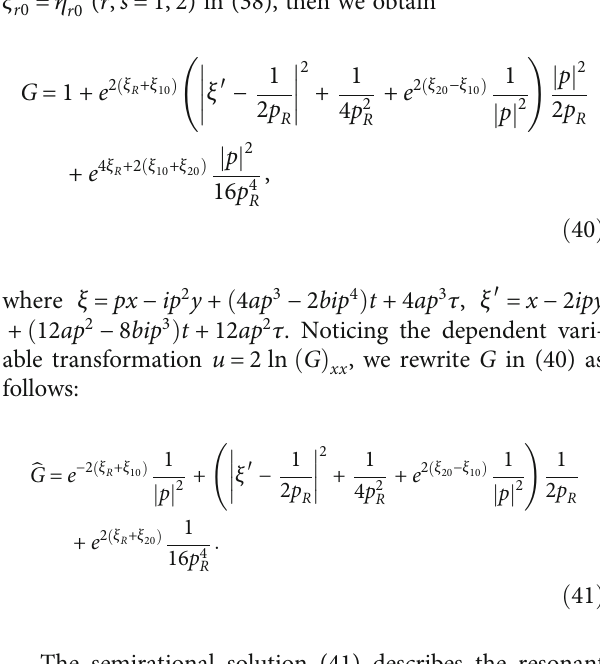
Figure 7: The multiple semirational solution u = 2 ln ð G Þ , where G is given by (36) with p 1 = 1 + i , q 1 = 1 − i , p 2 = 1 + ð 1/2 Þ i , q 2 = 1 − ð 1/2 Þ i xx , a = 1 , b = 1 , τ = 0 , c 11 = 1 , d 11 = 1 , c 21 = 1 + i , d 21 = 1 − i , C 11 = 1 , C 12 = C 21 = 0 , C 22 = 2 , ξ 10 = η 10 = ξ 20 = η 20 = 0 : (a) t = − 1/2 , (b) t = 0 , and (c) t = 1/2